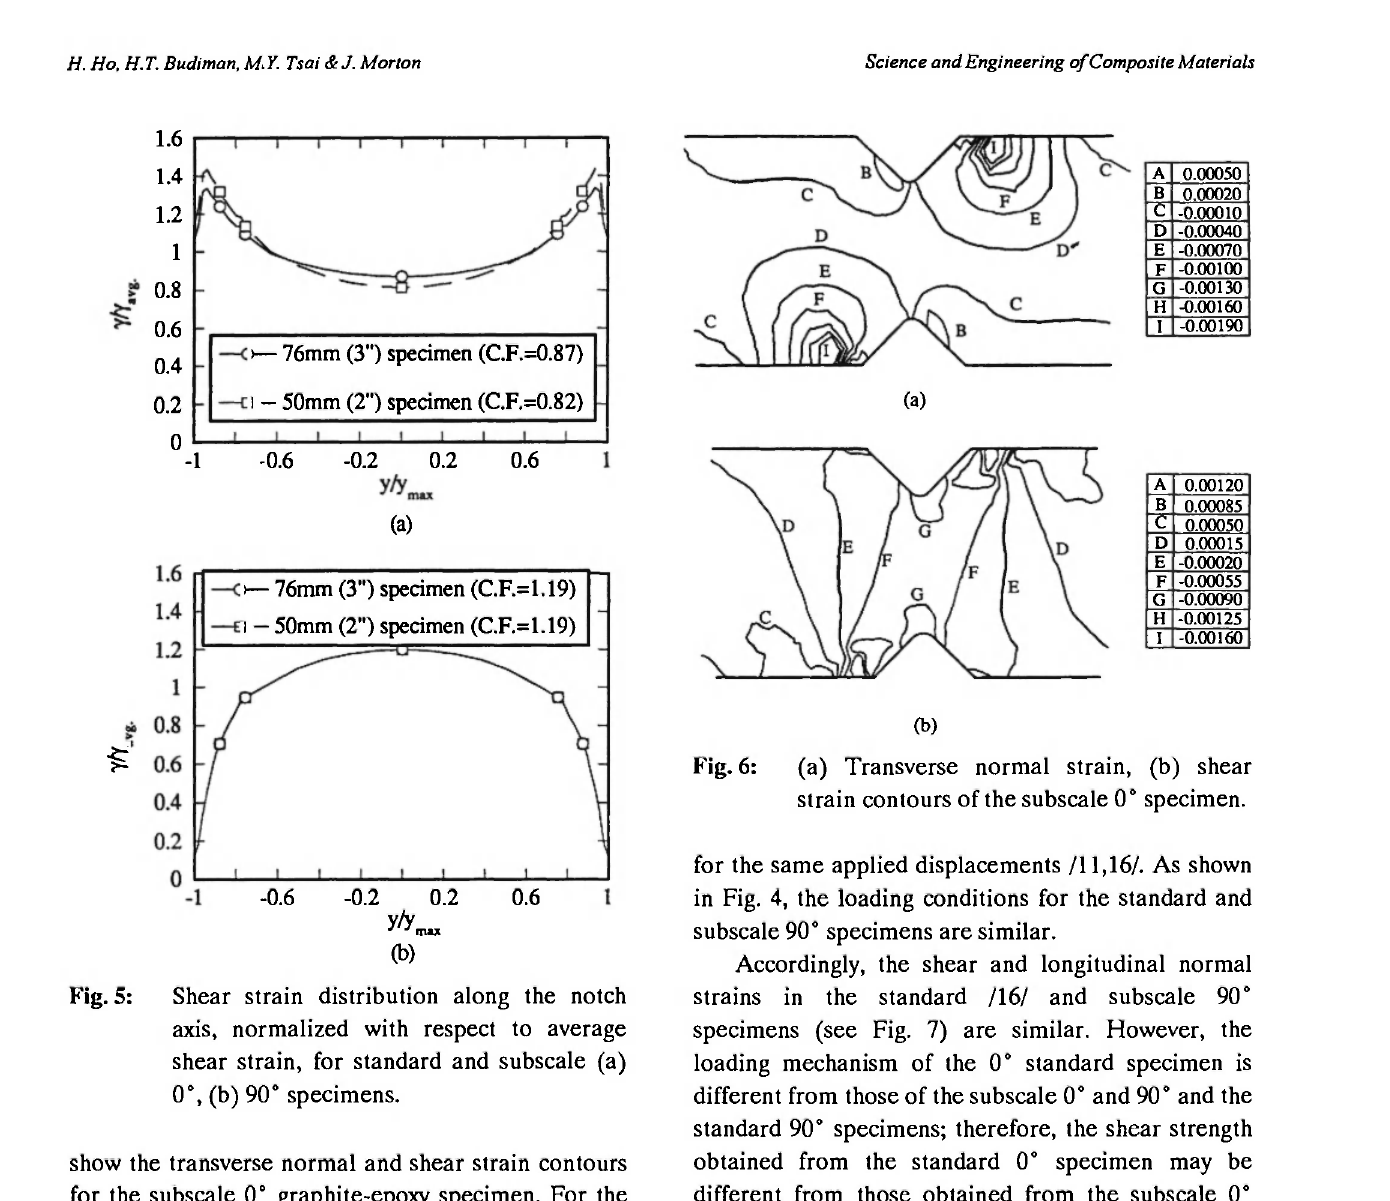
Fig. 5: Shear strain distribution along the notch axis, normalized with respect to average shear strain, for standard and subscale (a) 0% (b) 90° specimens. show the transverse normal and shear strain contours for the subscale 0° graphite-epoxy specimen. For the standard /16/ and subscale 0° specimens, the